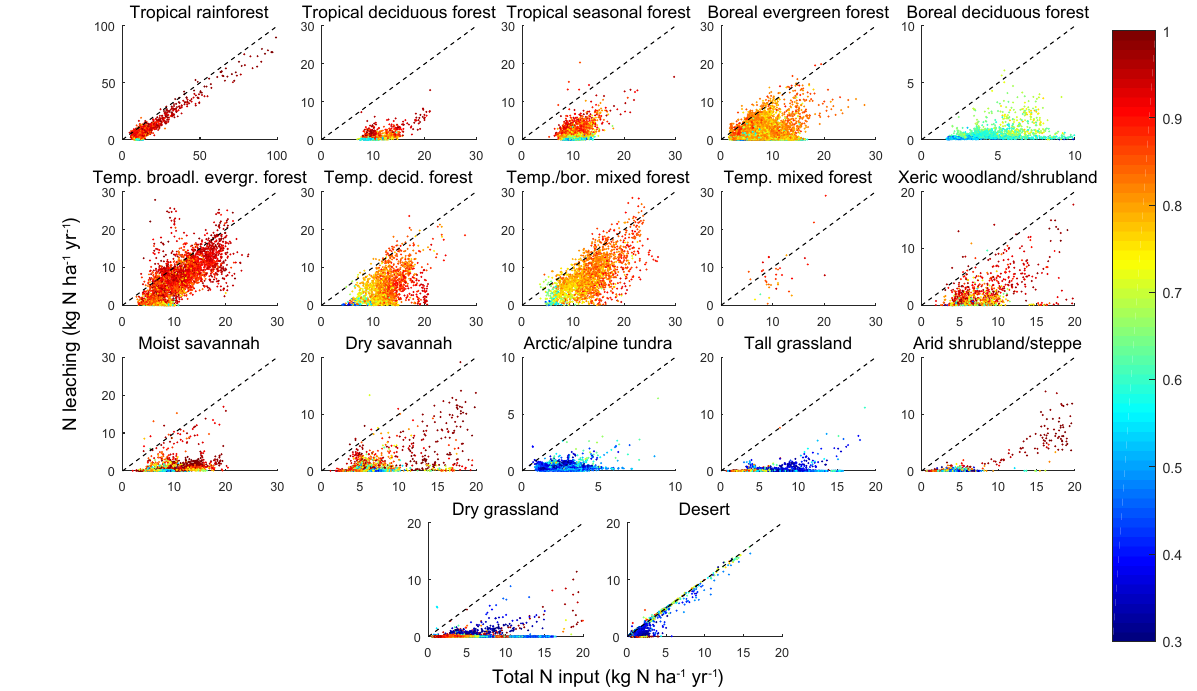
Figure 6. Mineral N leaching versus total N input (deposition + BNF) for the true historical simulation ( + Ndep + clim + CO 2 ) averaged over the period 1997–2006. Each point represents one grid cell. Colours indicate the mean N status. Dashed lines indicate the 1:1 relationship.